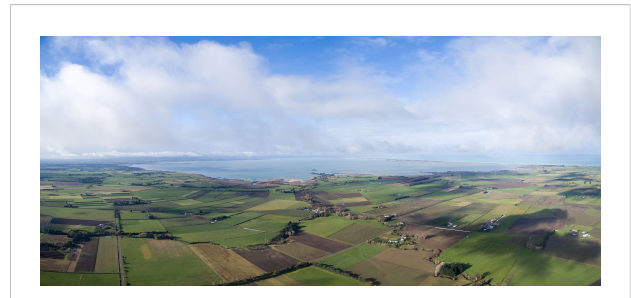
FIGURE 7 View of agricultural land adjacent to Te Waihora lake, Aotearoa (Lake Ellsemere, New